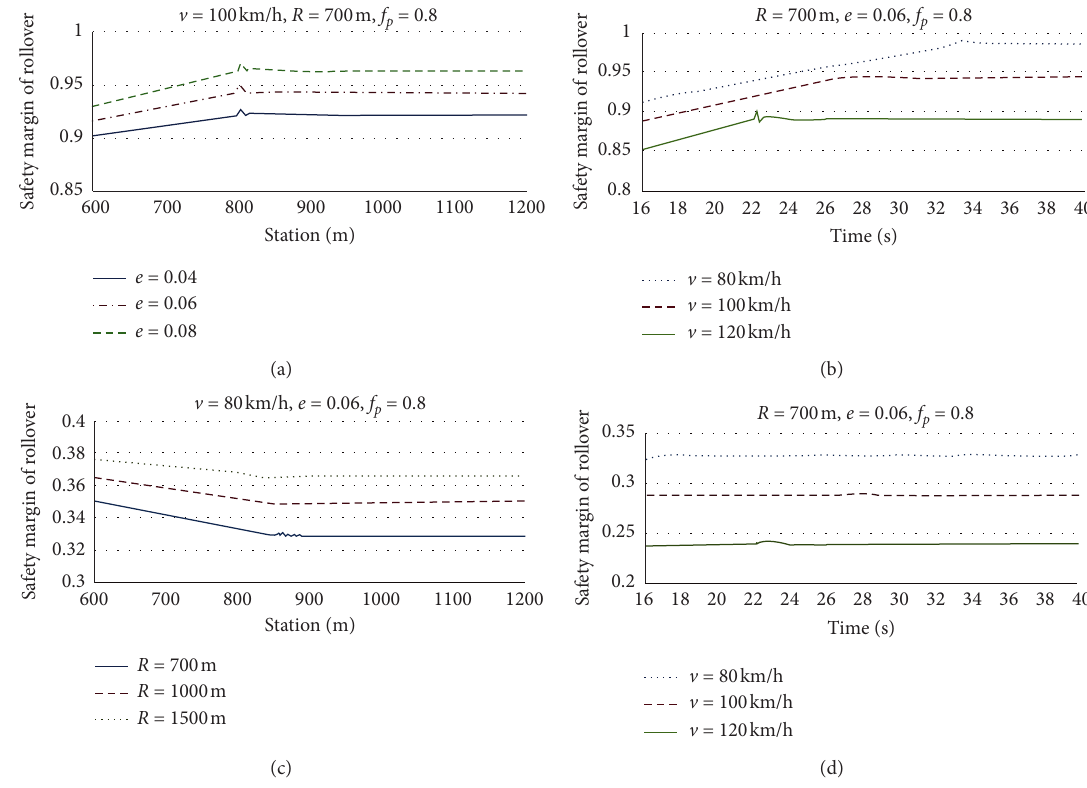
Figure 8: The effect of the significant single factor on the safety margin of vehicle rollover. (a) Effect of superelevation on the safety margin of rollover. (b) Effect of speed on the safety margin rollover. (c) Effect of the radius of the horizontal curve on the safety margin of rollover (M 3 ). (d) Effect of speed on the safety margin of rollover (M 3